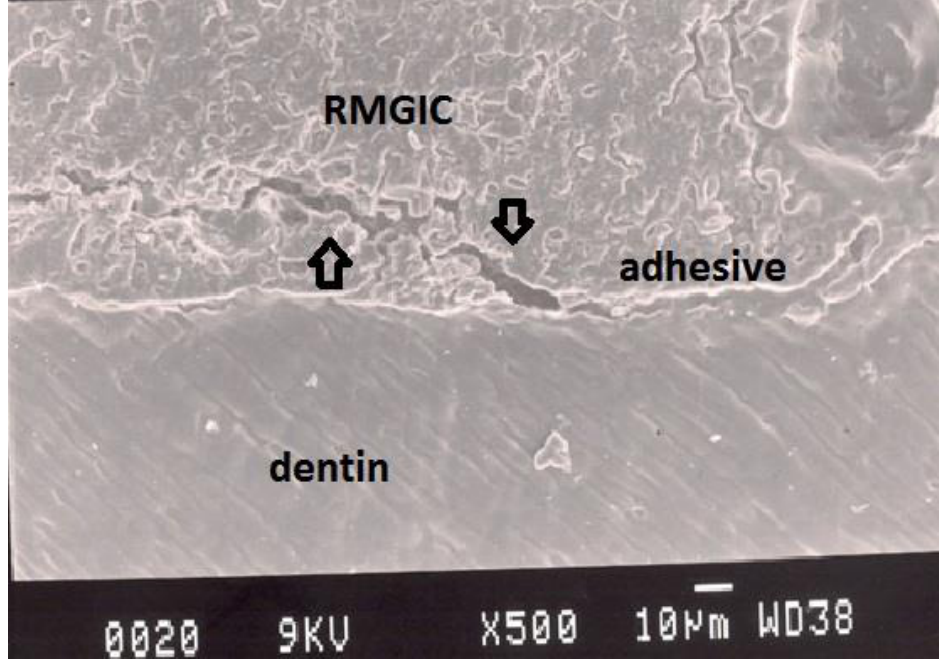
Figure 6. Representative SEM photomicrograph of a Group 5 specimen. The arrows indicate fracture within resin-modified glass ionomer cement (Vitremer), which may be due to the strong adhesion between adhesive and dentin.